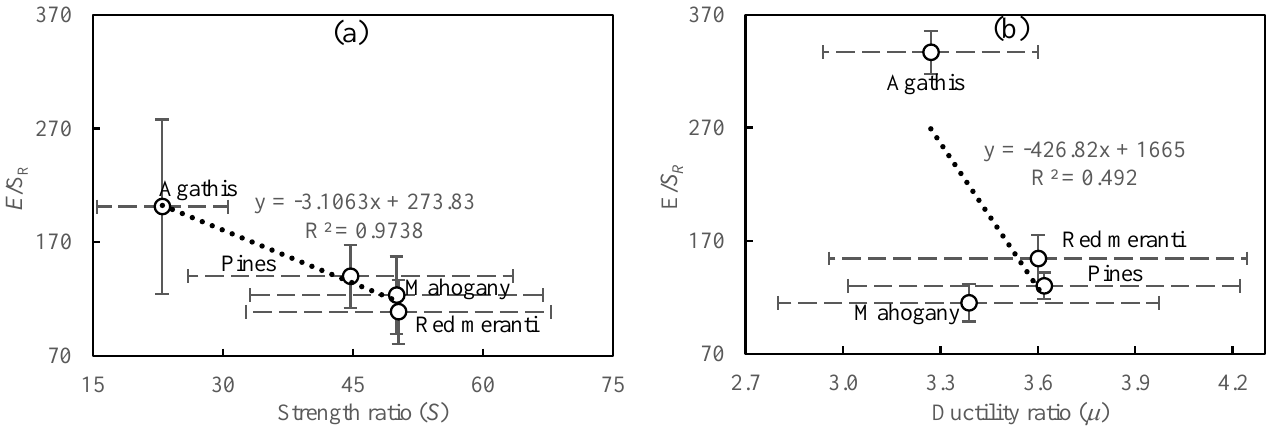
Figure 9. Correlation between the strength ratio ( S ) and E/S R of the small specimen ( a ) and between the ductility ratio ( µ ) and E/S R of the full-size specimen ( b ). Both strength ratio ( S ) and ductility ratio ( µ ) are negatively correlated with E/S R .